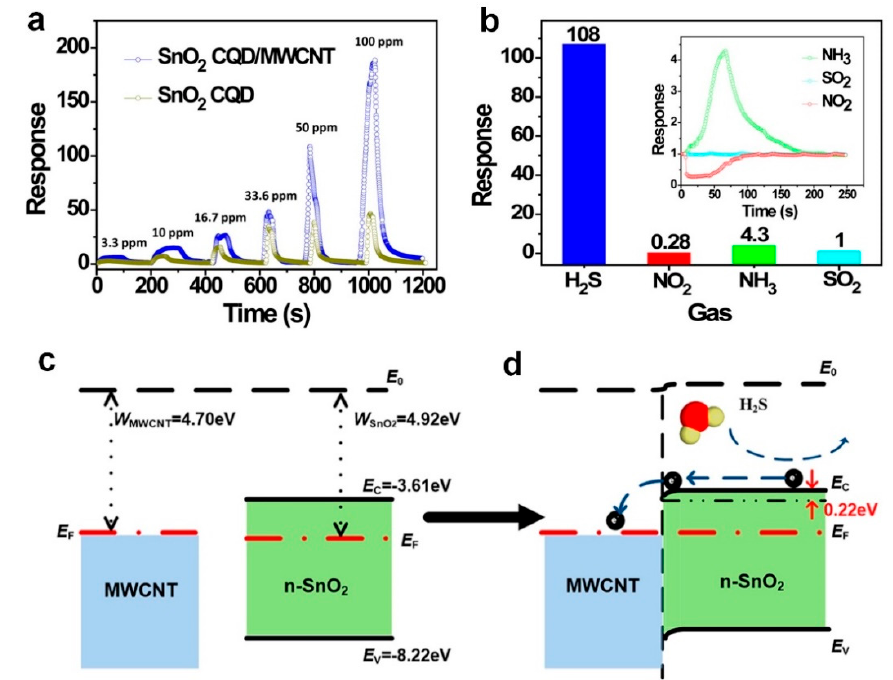
Figure 3. ( a ) Response of SnO 2 CQD/MWCNT nanocomposites and pristine SnO 2 CQDs sensors to